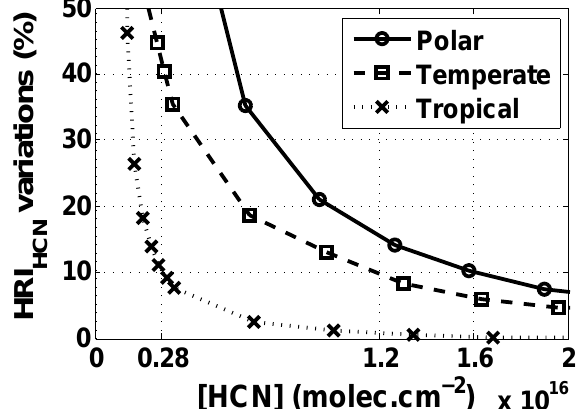
Figure 5. Variation of HRI HCN caused by a TC equal to ± 10K for the polar (solid line an circles), temperate (dashed line and squares) and tropical (dotted line and crosses)